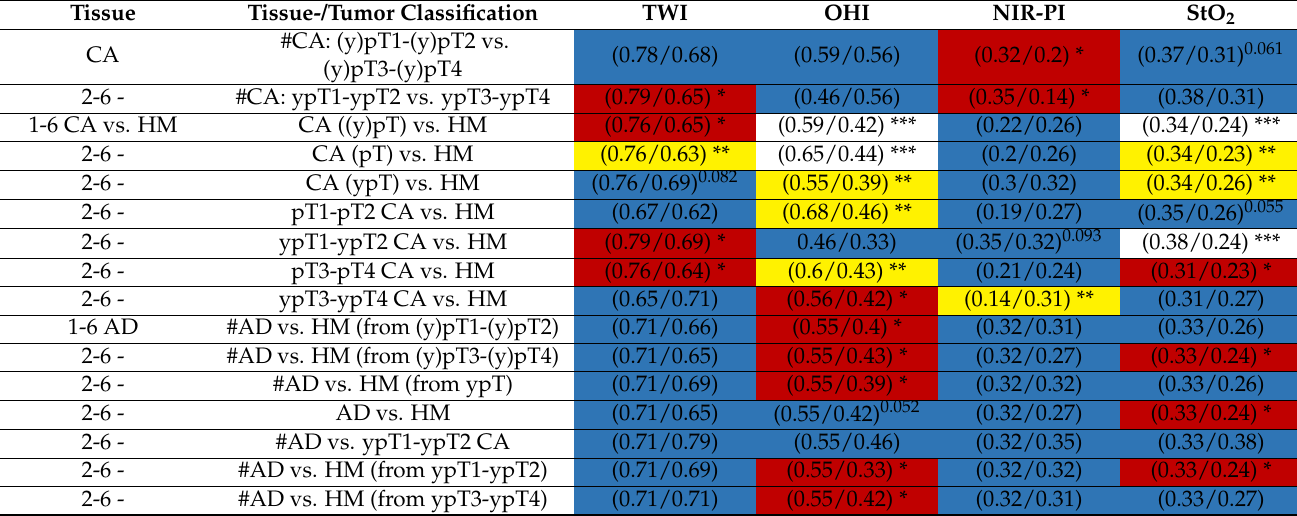
Table 2. Statistical comparison of the mean physiological parameter indices computed for different kinds of tissues (HM, AD, CA) and regarding different characteristics (neoadjuvant therapy, tumor classification); blue = no statistical difference p >0.05; red = * p ≤ 0.05; yellow = ** p ≤ 0.01; white = *** p ≤ 0.001. The symbol # denotes independent datasets. Tissue Tissue-/Tumor